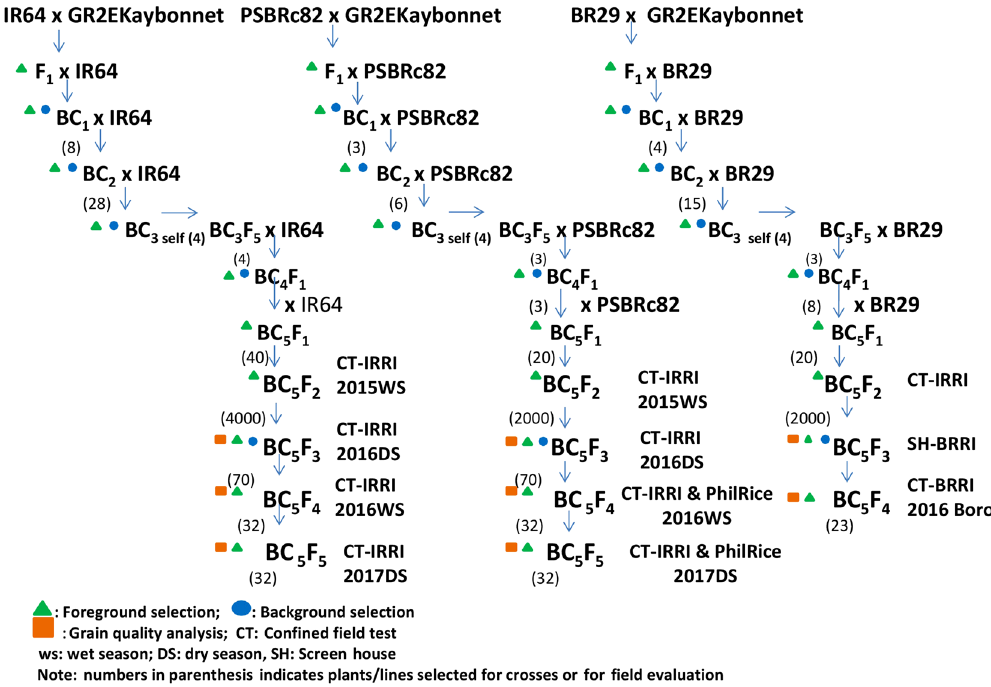
Figure 4. Development and evaluation of GR2E introgression